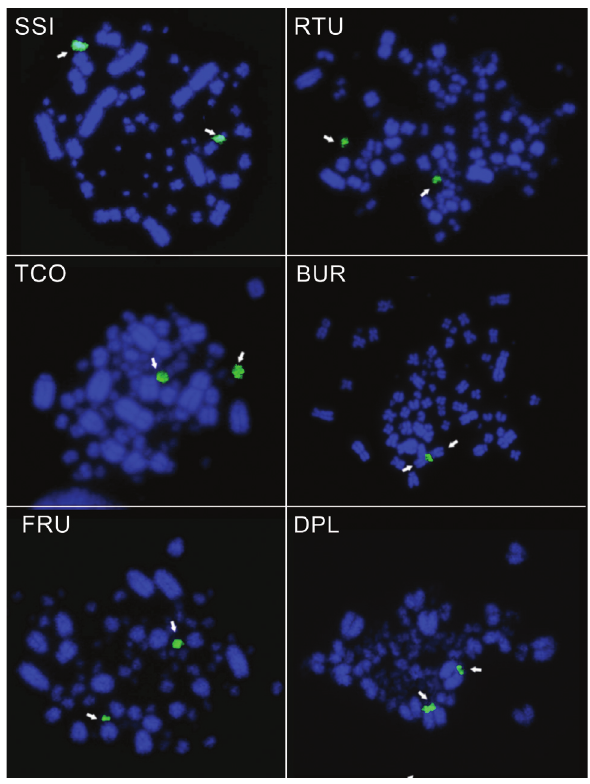
Figure1 -Examplesofthemetaphasesanalyzedinthepresentstudyusing the 18S rDNA probe (green) to identify the chromosomes (blue) carrying 45S rDNA sites (arrows). The acronym shown in the upper right corner of each metaphase indicates the species: Syrigma sibilatrix (SSI), Ramphastos tucanus (RTU), Tachyphonus coronatus (TCO), Buteogallus urubitinga (BUR), Furnarius rufus (FRU), and Dendrocolaptes platyrostris (DPL).